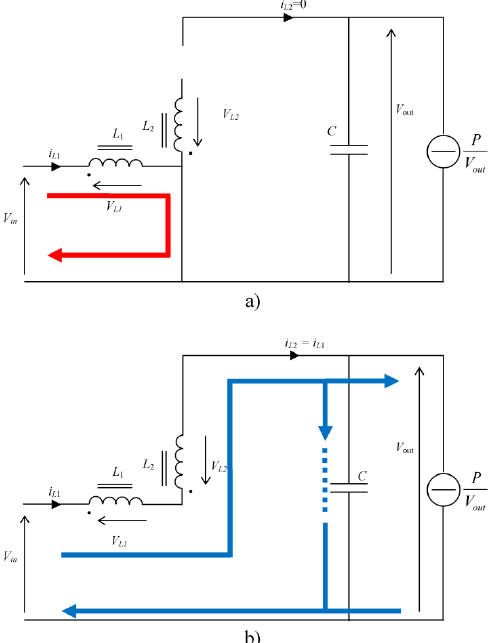
Figure 5. Coupled inductor DC–DC converter in boost mode during ( a ) T on and ( b ) T off.